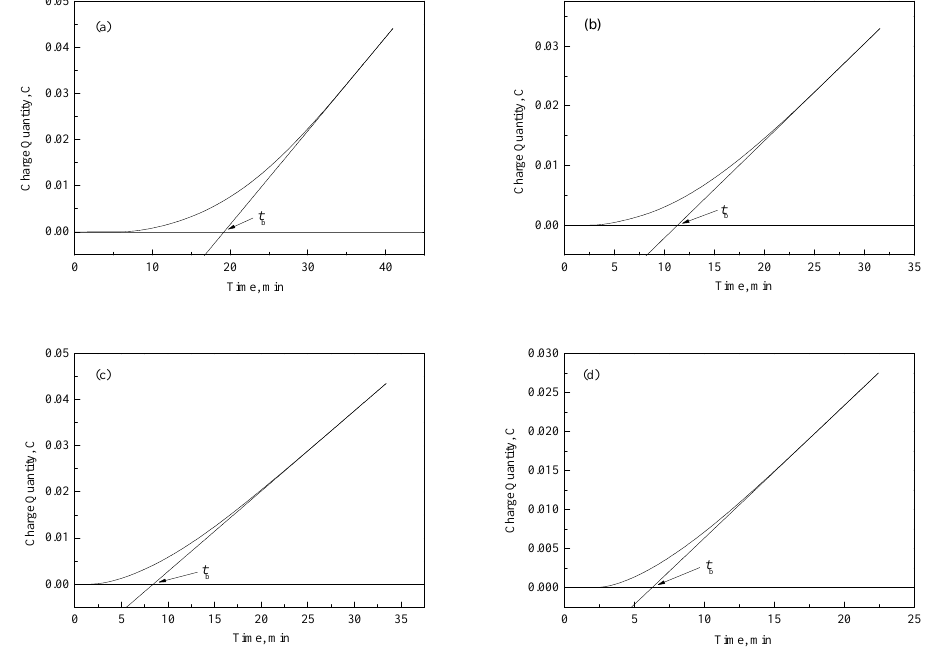
Figure 8. Hydrogen permeation curves (charge quantity vs. time curves) of ultra-low carbon enamel steel annealed at different temperatures ( a ) 580 °C; ( b ) 630 °C; ( c ) 680 °C; ( d ) 730 °C.